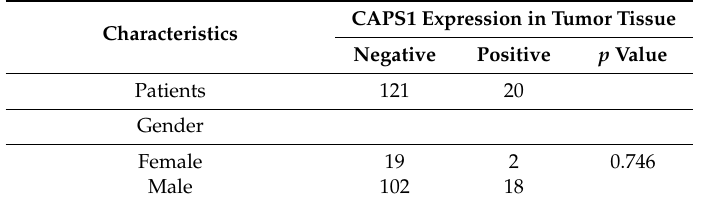
Table 1. Correlation between CAPS1 and clinicopathologic characteristics.